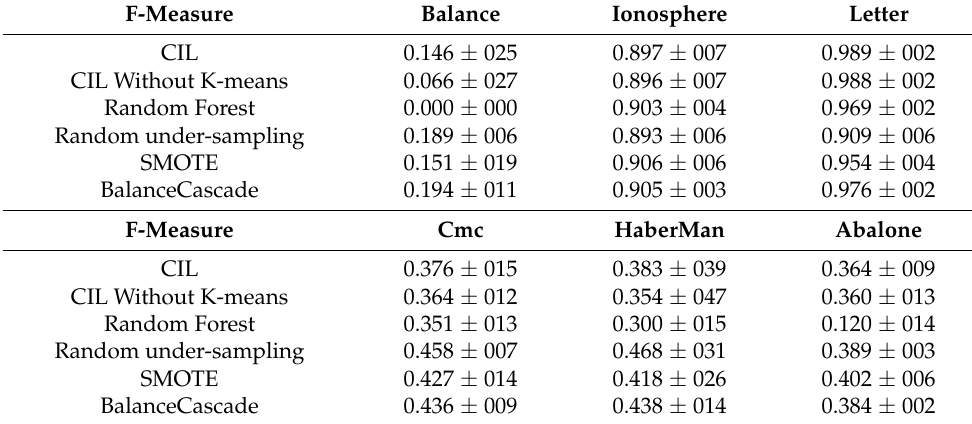
Table 5. F1 scores on UCI data